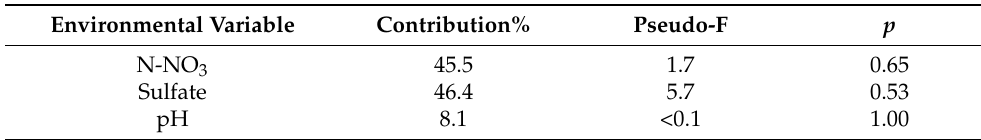
Figure 5. Canonical correspondence analysis (CCA) showing the relationship between major soil chemical parameters and functional categories of the samples. Based on the CANOCO adviser, N-NO 3 , sulfate and pH were selected as major factors influencing soil functional hit categories. The contribution of each variable has been explained in Table 3. Table 3. The disparity in functional hit categories within samples best explained using a forward preference of environmental